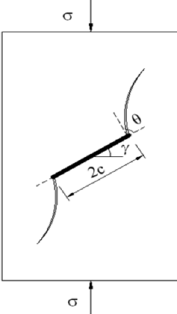
Figure 1. Schematic Diagram of the Wing Crack Growth Model.